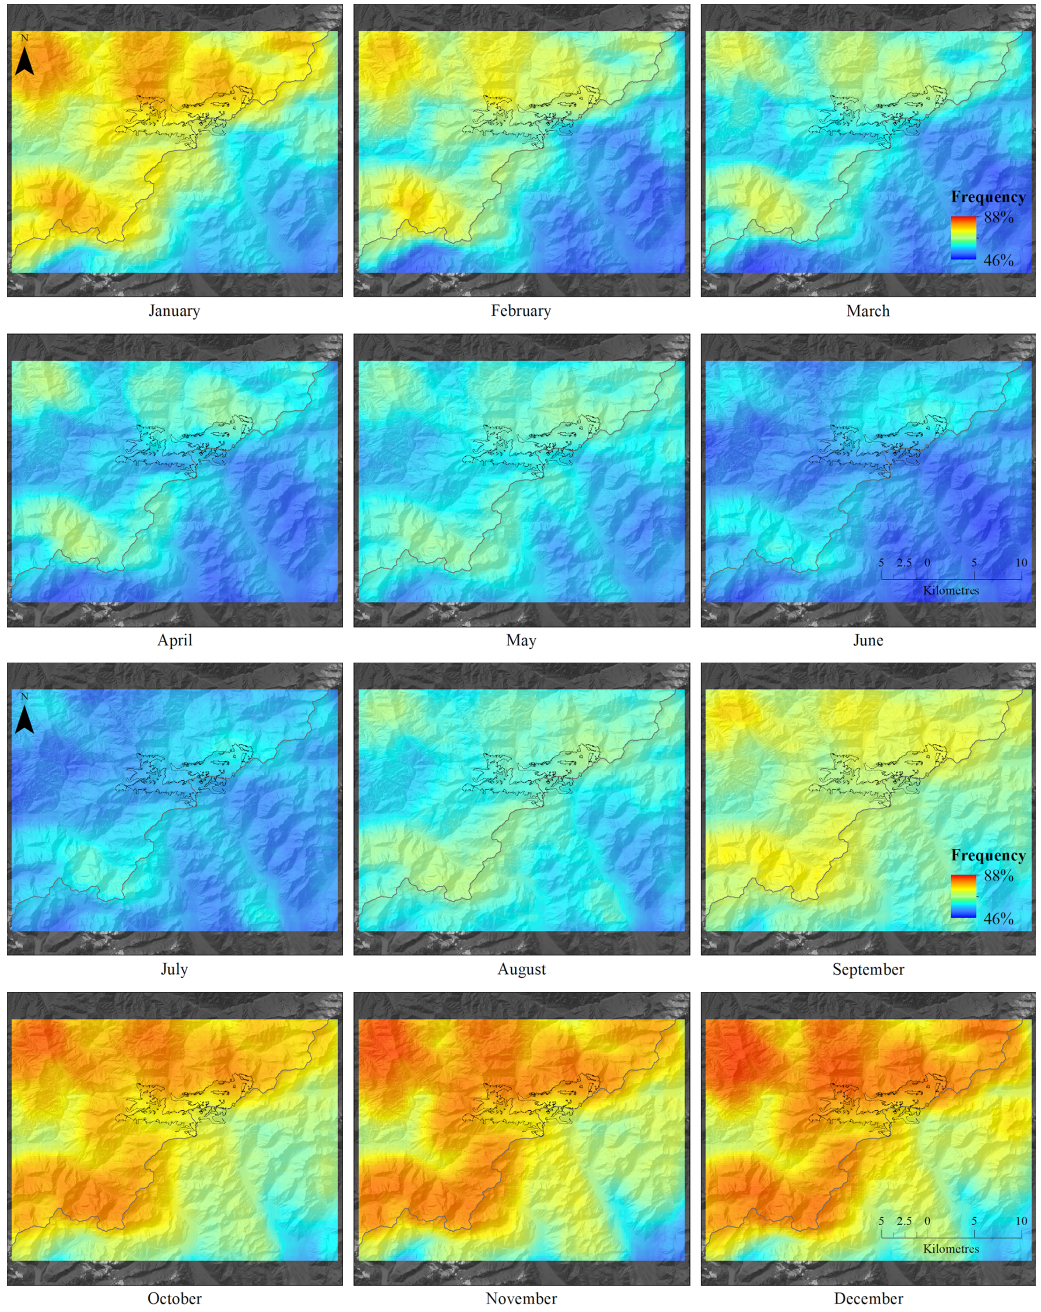
Figure 15. Frequency of monthly cloud cover per pixel in Terra MODIS images over the Southern Alps from 2000 to 2017 (frequent cloud cover is displayed in red). The Main Divide of the Southern Alps is shown running southwest to northeast, with the position of the GoEA marked in